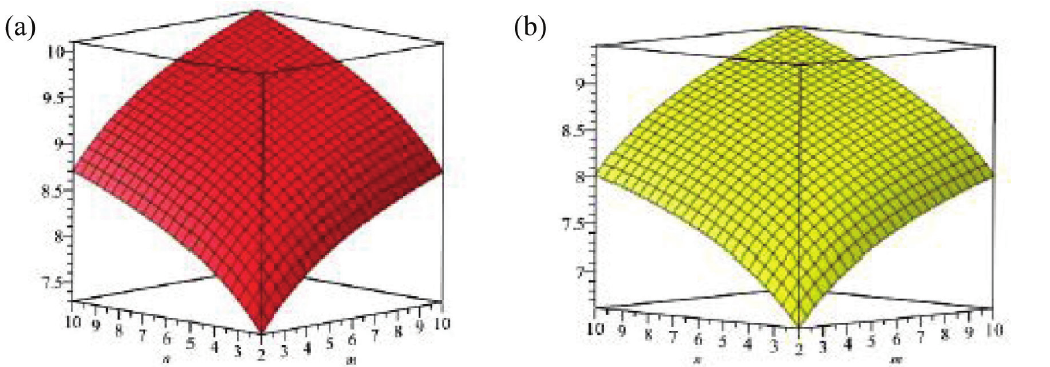
Figure 9: (a) The hyper Zagreb entropy, (b) the forgotten